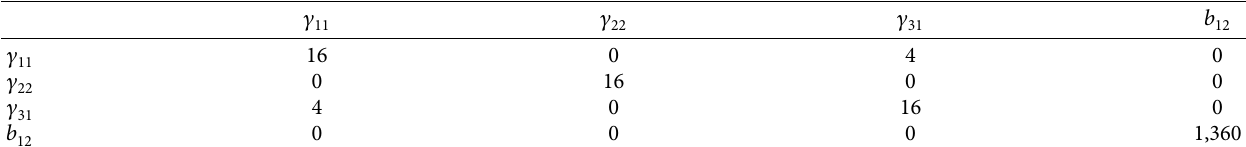
Table 10: Asymptotic information matrix for Example 2 based on the 3SLS D -optimal